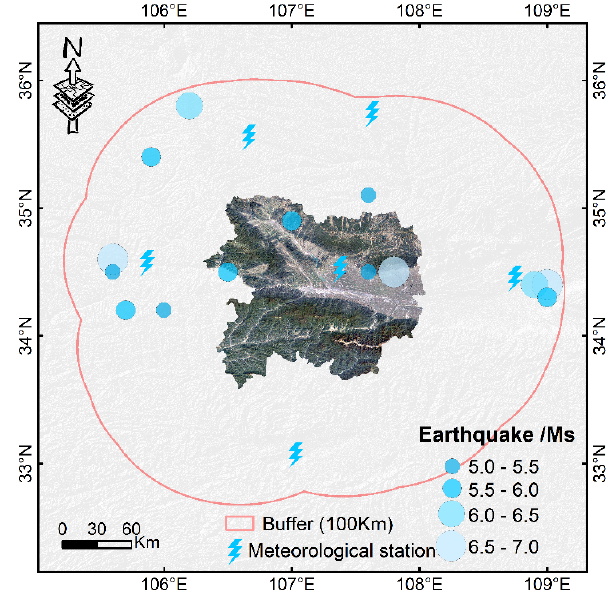
Figure 2. Locations of six meteorological stations and seismic sites.